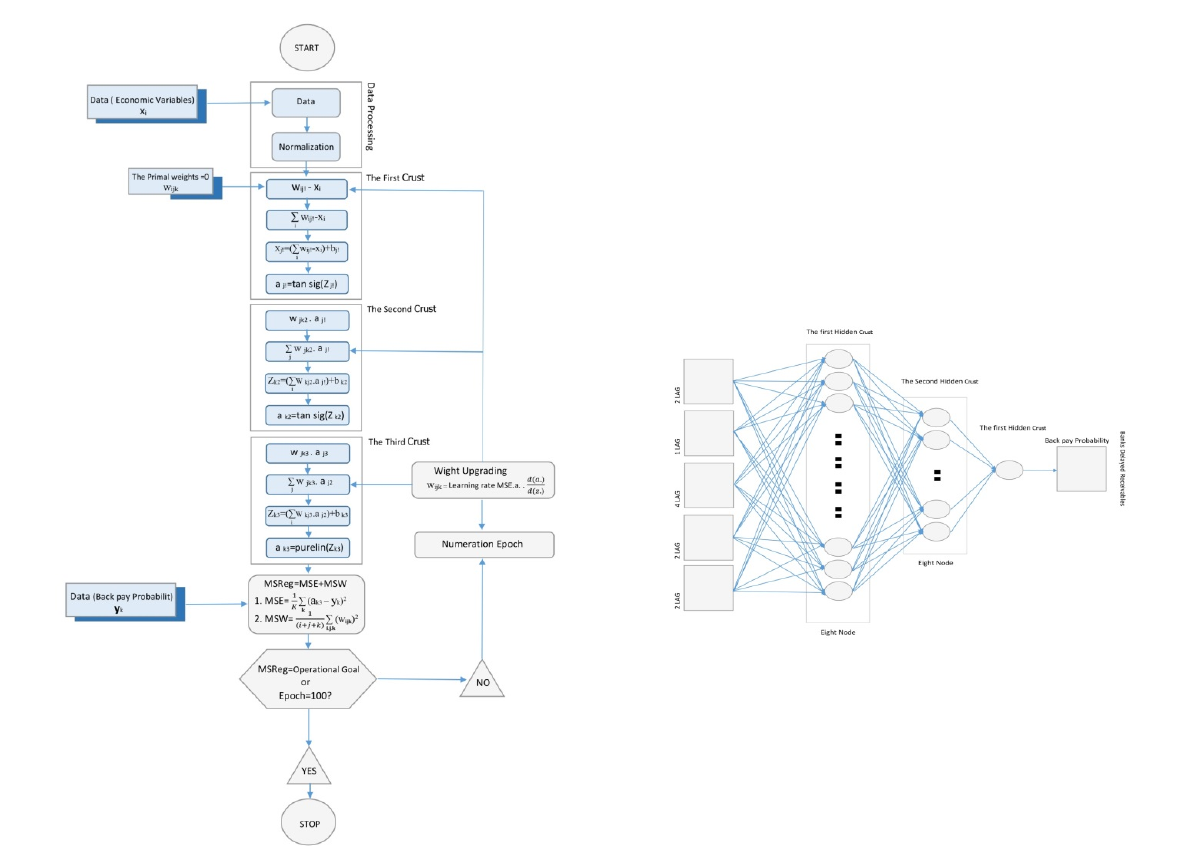
Fig. 1. The proposed structure of neural network Fig. 2. Network Structure